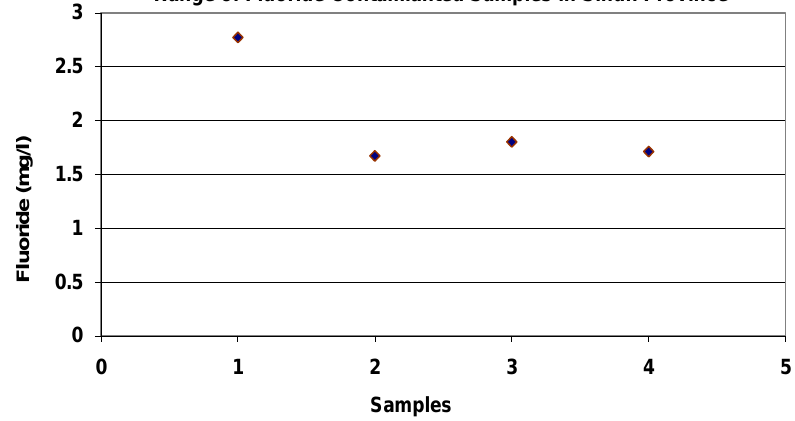
> 1.5mgL − 1 ) in Sindh province. Figure-4: Range of fluoride contaminated samples (>1.5mg/l) in Sindh Province Figure 4. Range of fluoride-contaminated samples (